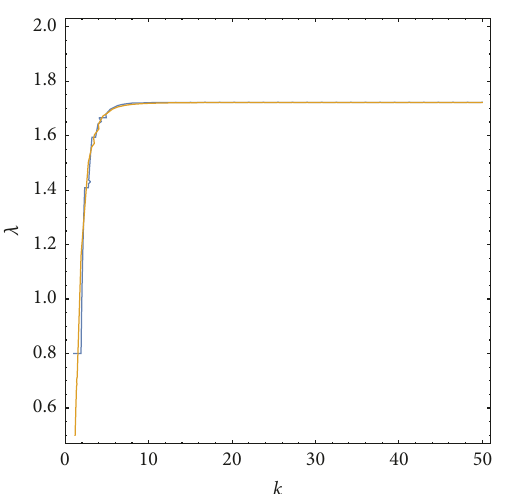
Figure 1: The blue curve shows the variation of 𝜆 as a function of 𝑘 obtained from (12). The yellow curve shows the plot of the function 𝜆 (−𝛼 /(𝑘 + 𝑘 ) ] 0 ) of 𝑘 , with 𝜆 0 exp 0 0 = ] 0